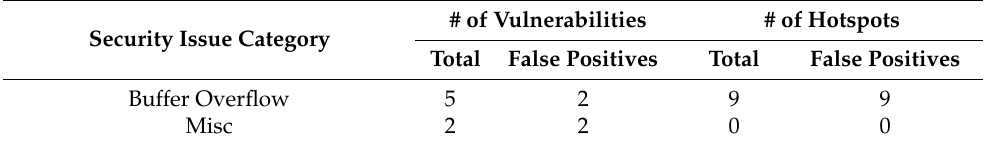
Table 9. Number of security issues of different categories in